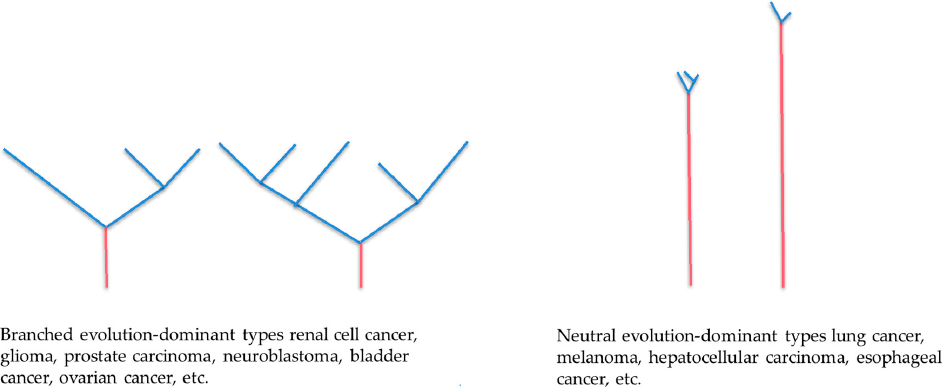
Figure 1. Phylogenetic trees for the cancer genome. These schemas of genomic evolutionary trees indicate how cancer evolves through branched evolution and neutral evolution. The red and blue line represents a common mutation and a subclone mutation, respectively. The branch length indicates evolutionary distance and is correlated with the number of nucleotide substitutions.